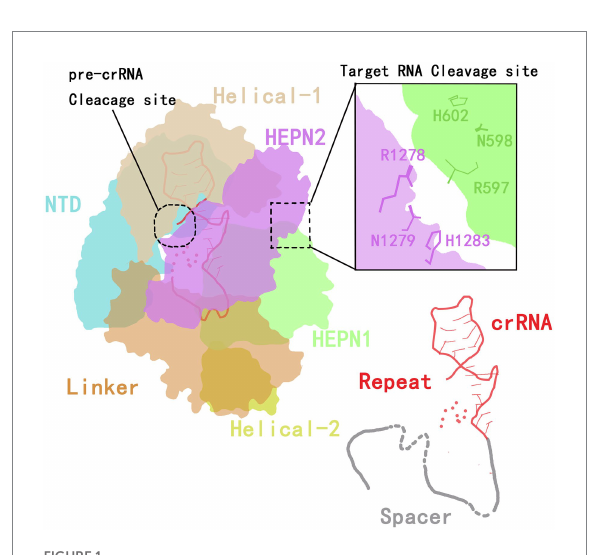
FIGURE 1 The crystal structure of Cas13a in the crRNA